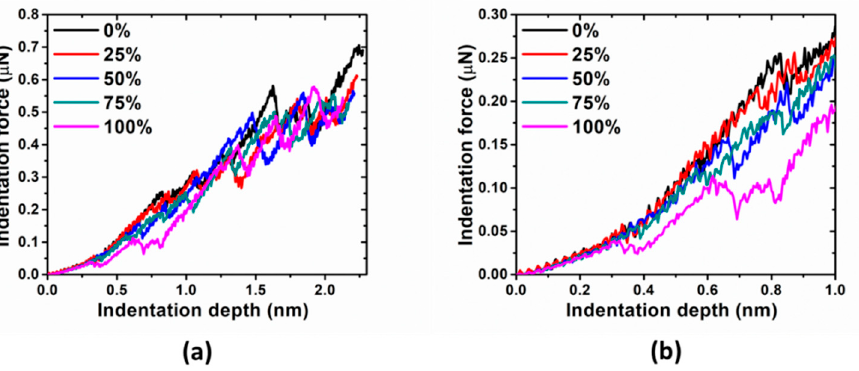
Figure 17. ( a ) Indentation force vs. indentation depth with different prestrains for Cu sample under reloading. ( b ) Indentation force in early stage of indentation.